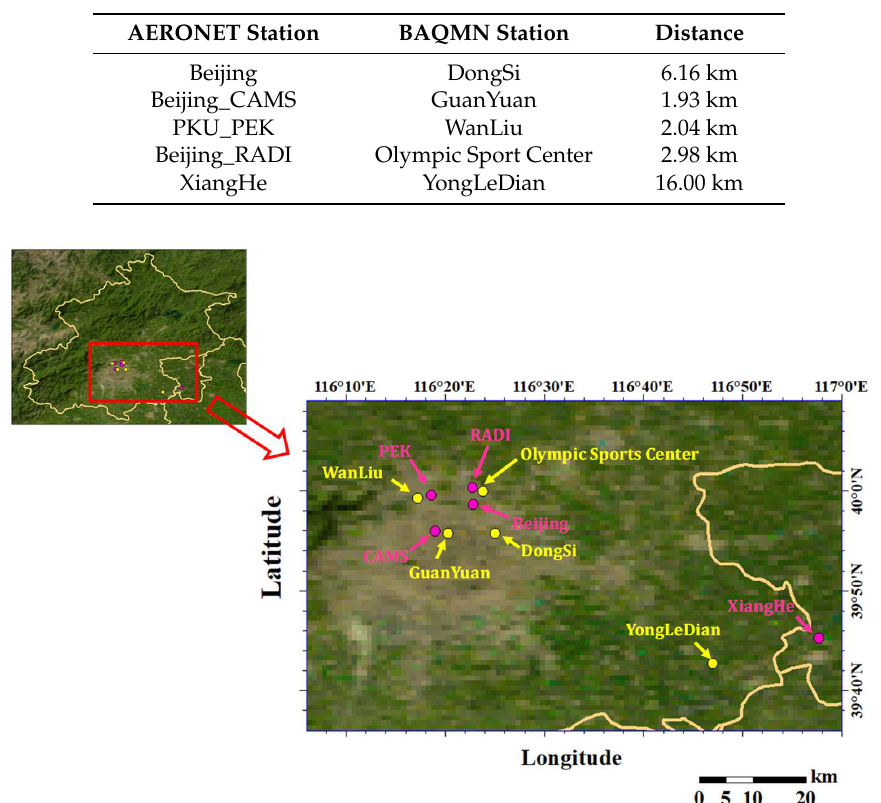
Figure 1. Locations of AErosol Robotic NETwork (AERONET) stations and air quality monitoring stations in the Beijing area.